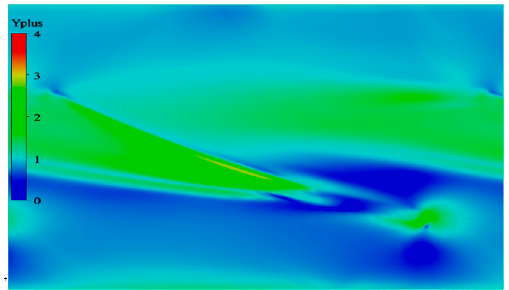
Figure 3. y + distribution of blade tip.